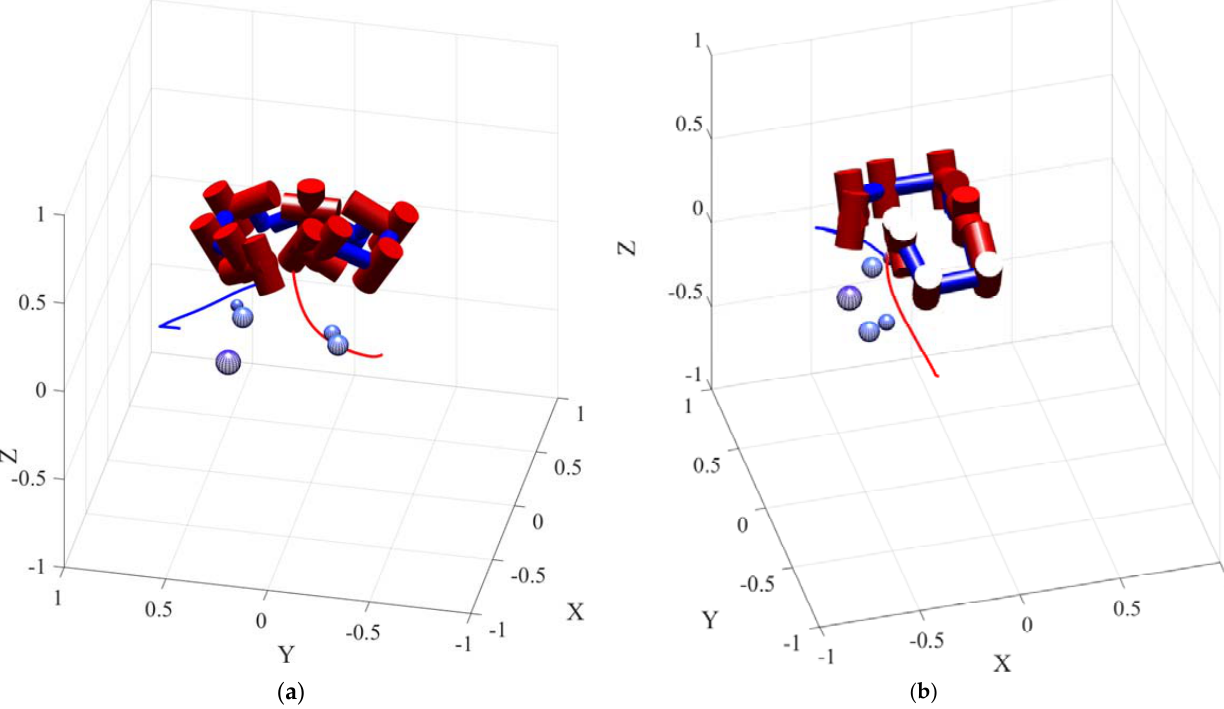
The slave arm Figure 13. Static obstacle avoidance.